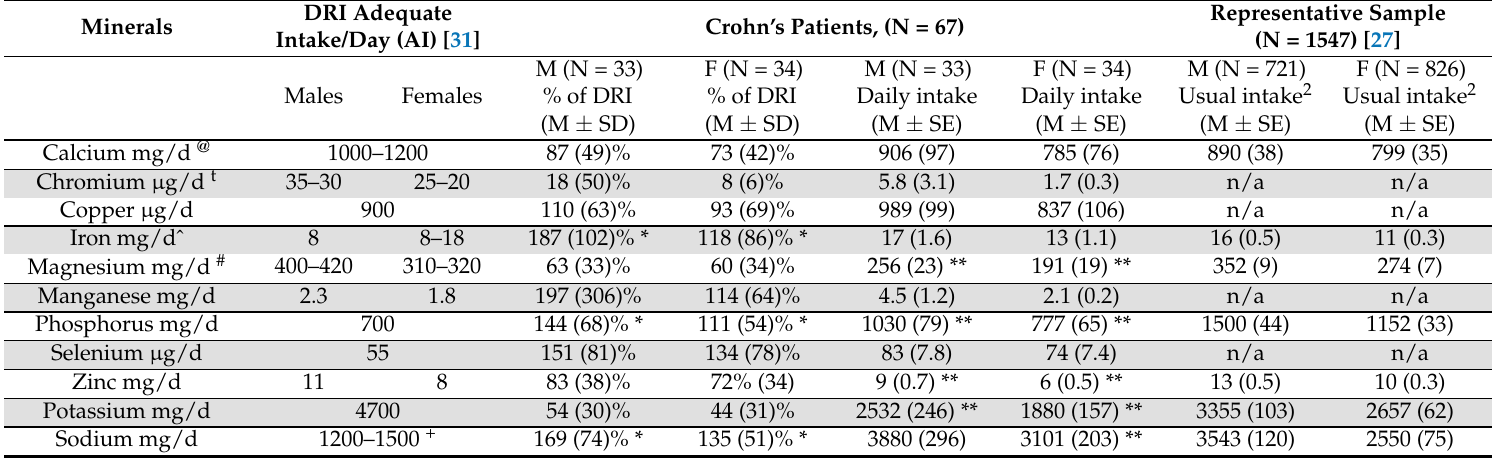
Table 4. Mineral intake compared to a representative